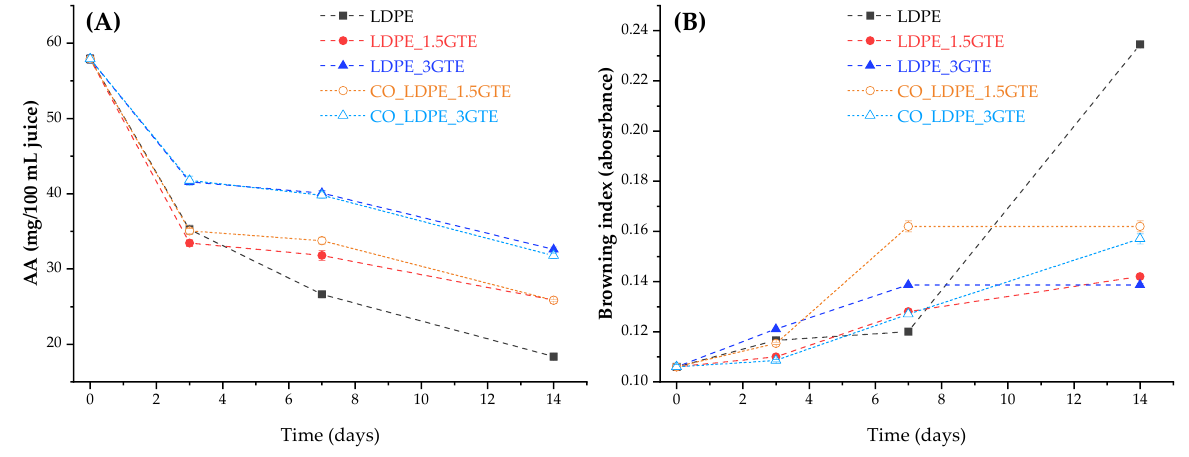
Figure 1. The content of AA (A), and browning index (B) in orange juice packed with neat LDPE films and active LDPE films containing GTE stored at 4 °C for 14 days.